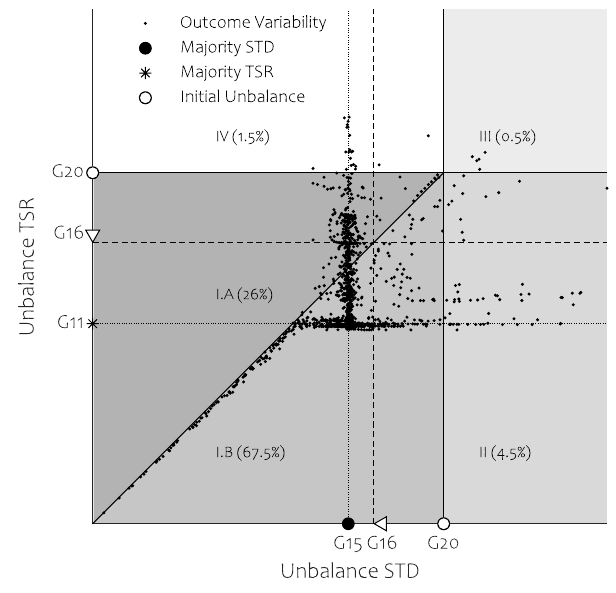
Figure 6. Comparison of the balancing outcome of the standard (STD) and TSR procedure.